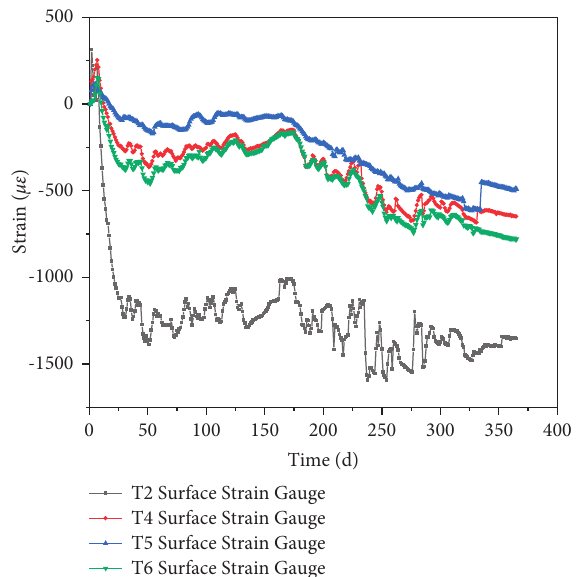
Figure 17: Surface shrinkage strain curves of T2, T4, T5, and T6 specimens with time.